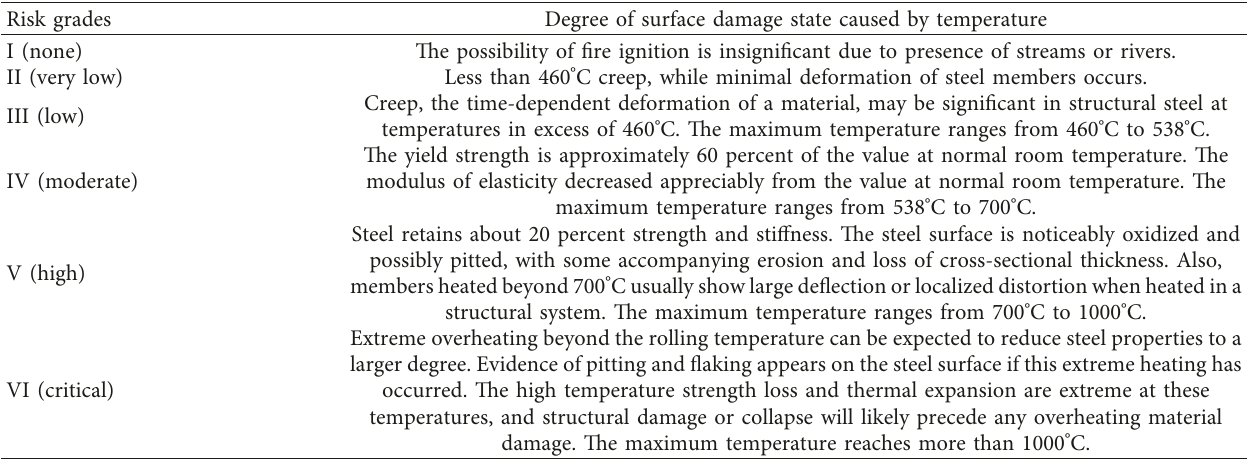
Table 4: Risk grades of steel bridges [9, 15, 19–23].